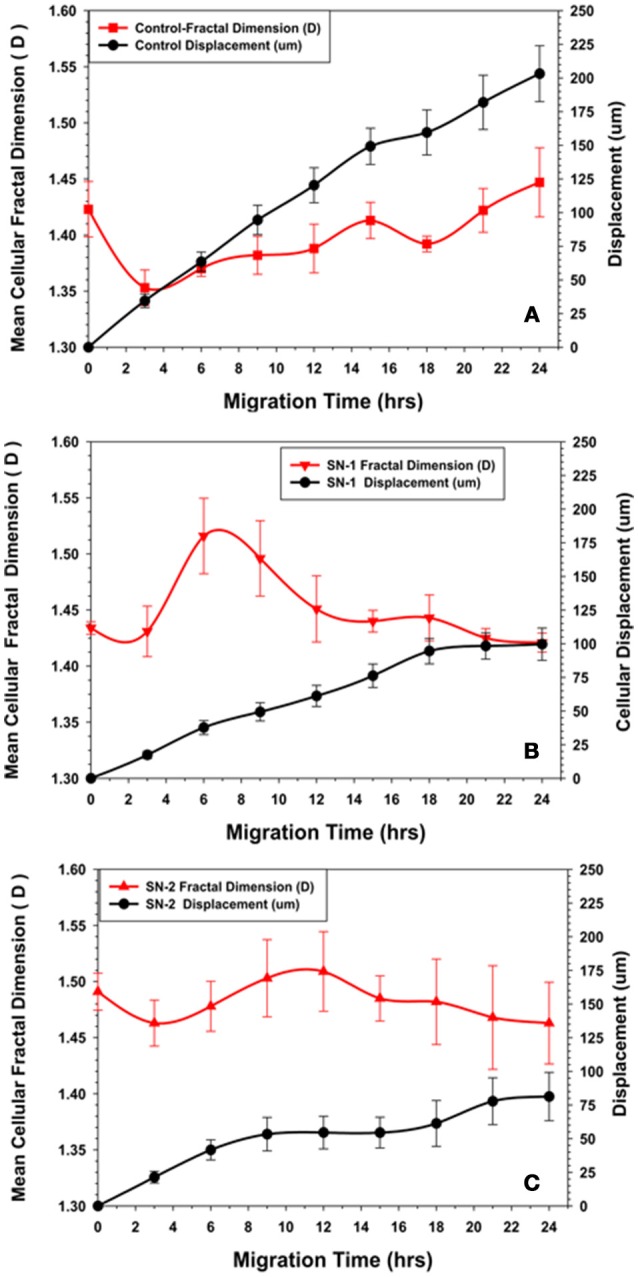
Comparison of changes in fractal dimension of MSCs with their displacement kinetics in the presence or absence of NO. (A) Control MSCs. The fractal dimension (D) of the migrating MSCs was initially decreased during the first 2–3 h of migration, suggesting reorganization of the cytoskeleton to a more ordered state during this time. The subsequent increase in (D) to an essentially steady state value with minor oscillations suggested a certain degree of disorder of the cytoskeleton maintained during directed migration into the wound area. (B) Group SN-1. MSCs that were treated with NO at the onset of migration, the fractal dimension (D) started at the same value as seen for the controls, then immediately decreased during the first 2–3 h of migration, suggesting reorganization of the cytoskeleton to a more ordered state during this time period. Subsequent slow migration was accompanied by a significant increase in (D). This suggested that NO affected migration by increasing disorder or chaos associated with the MSC's cytoskeleton. The (D) value then declined to a steady state value similar to that seen at time = 0, when the MSCs ceased their movement all together. (C) Group-SN-2. MSCs that were pretreated with NO for 7 days prior to migration revealed a significantly elevated (D) value before the start of migration i.e., at time = 0. There was a minor decrease in (D) as these cells began their cellular movement as seen in the other groups. During the phase of limited migration of this group, the (D) value increased slightly then declined to an elevated steady state value as the MSCs ceased their directed movement.